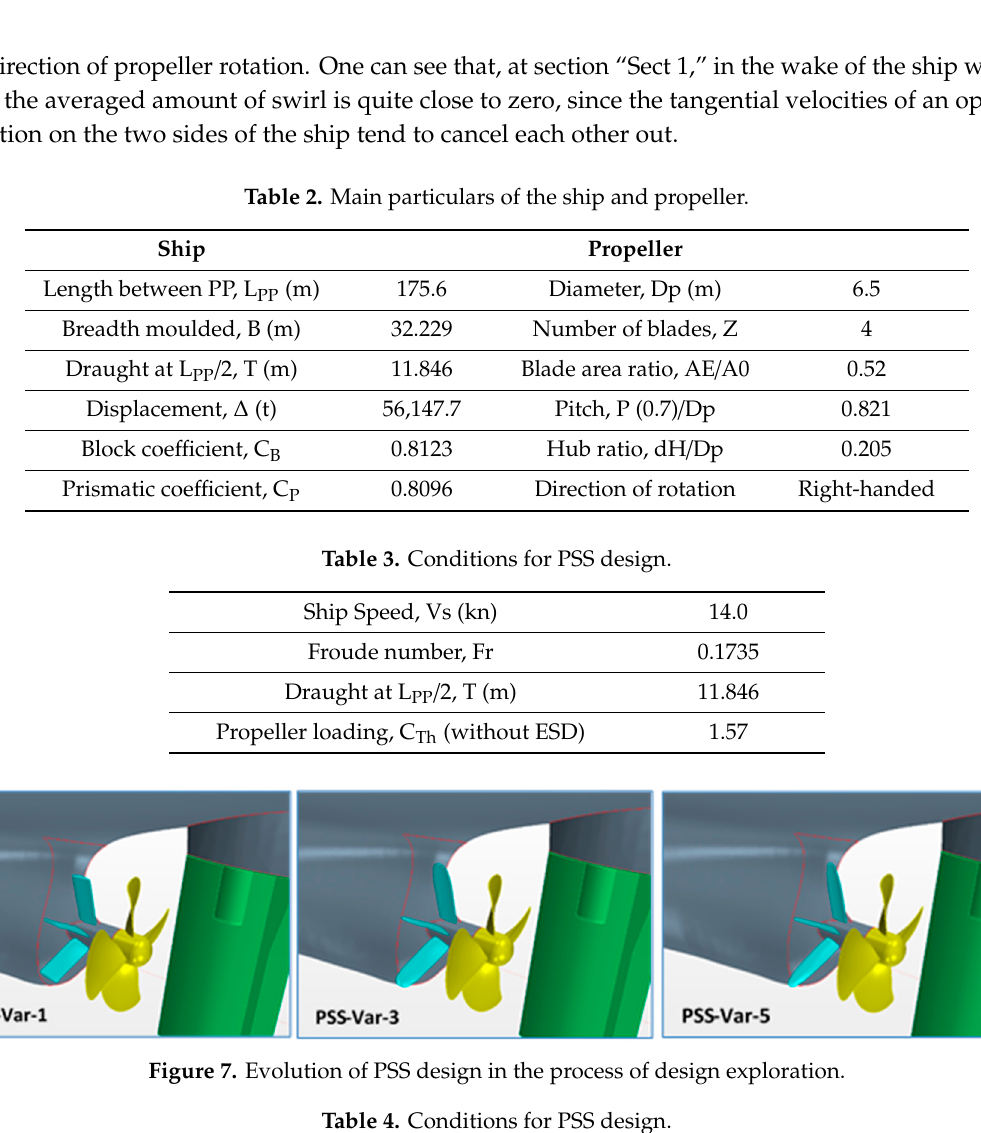
Table 3. Conditions for PSS design.